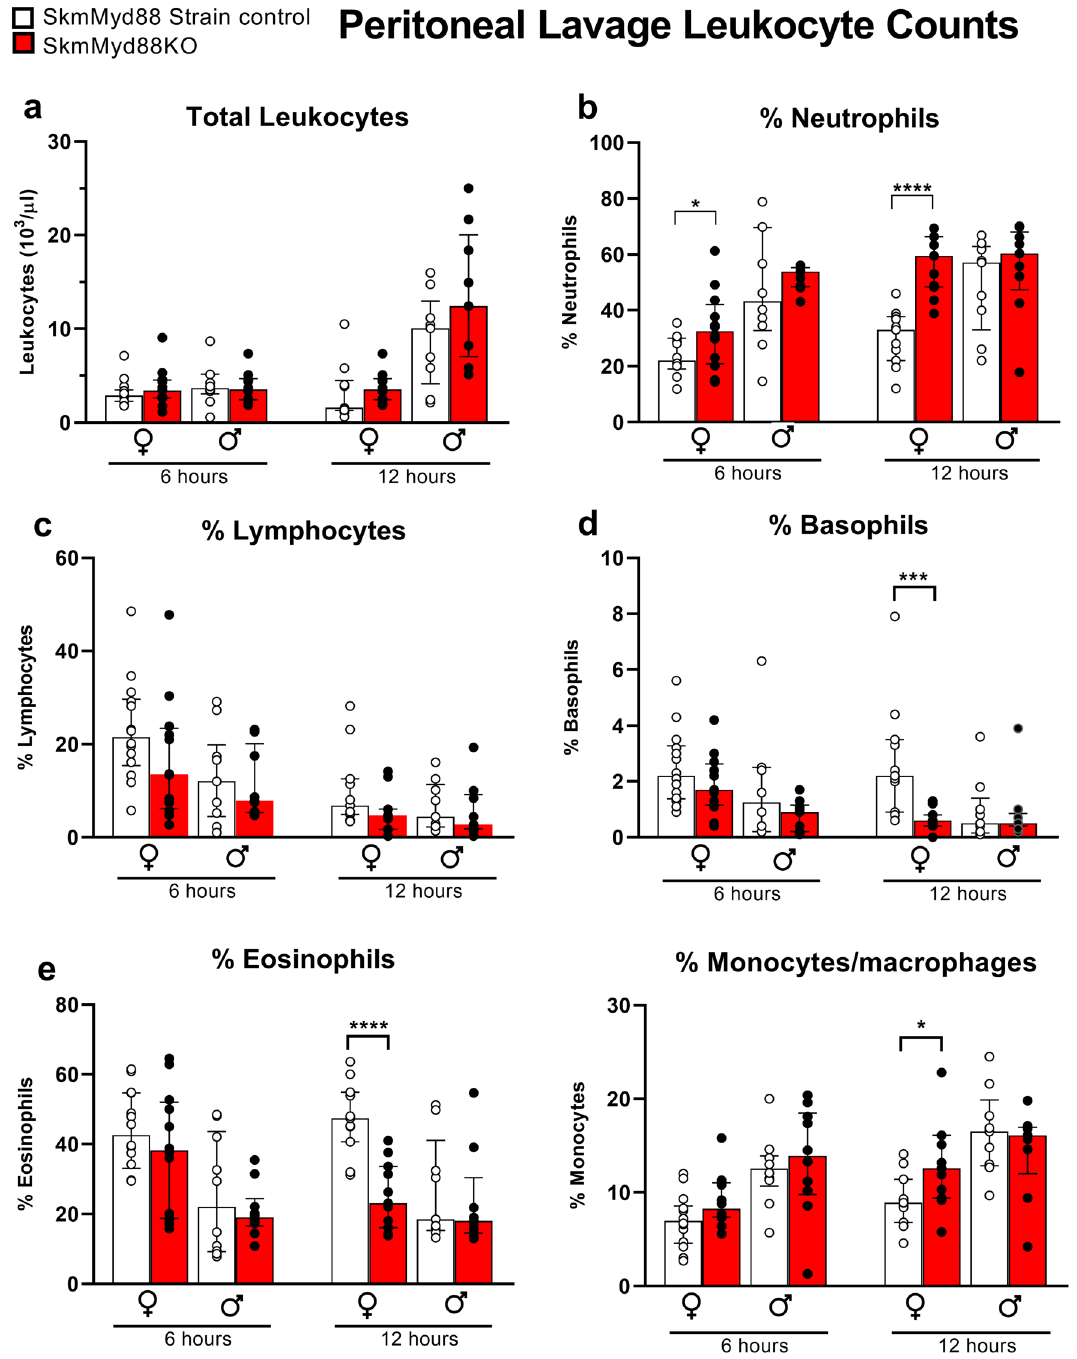
Figure 4. Responses of skmMyd88 knockout on immune cell populations in the peritoneum. SkmMyd88KO red bars, strain matched control, white bars. Groups were tested by orthogonal comparisons within sex and compared to strain matched controls *P < 0.05, **P < 0.01. n = 9–12 in each group. Data expressed as medians ± 25–75% quartiles. All data met a false discovery rate of <